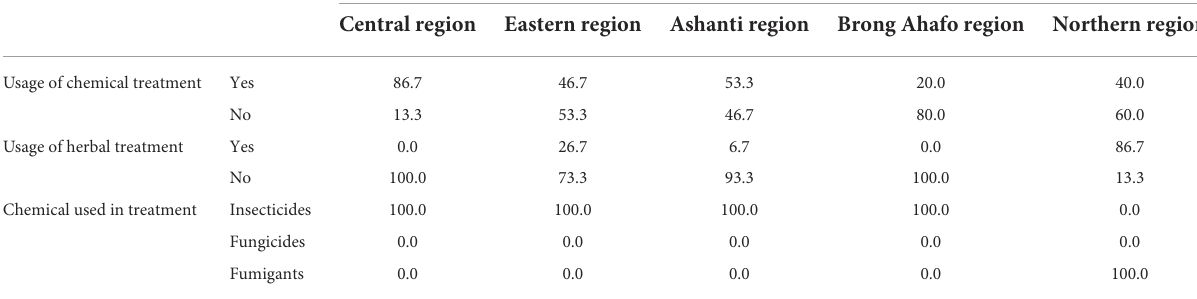
TABLE 7 Different treatment types used by farmers for storage of shelled maize grain.